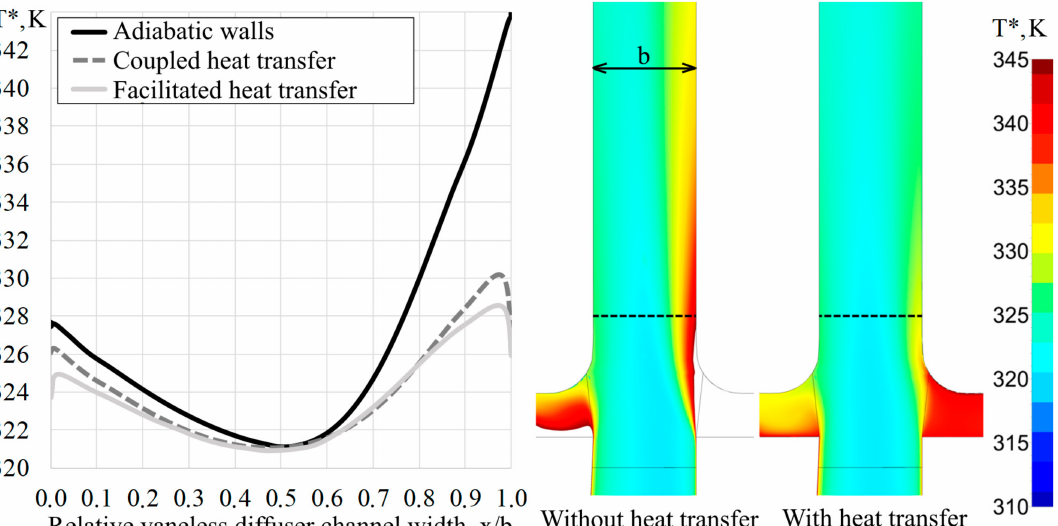
Figure 6. The profiles of temperature at the entrance to the bladeless di ff user for the three variants of Figure 2. show that disk friction when accounting for heat exchange increases approximately 10% according to the model calculation with the adiabatic walls. The increase in the coe ffi cient of